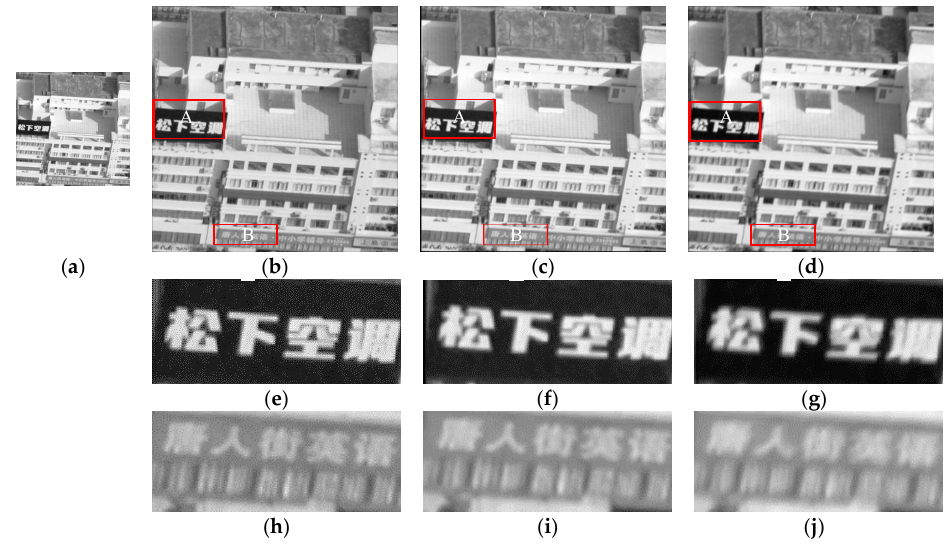
Figure 15. Actual results of the second set of experiments using the three methods. The images enclosed in a red box are the details of the three different algorithms. ( a ) Original LR image; ( b ) image based on the proposed algorithm; ( c ) image based on the blind SR reconstruction algorithm; ( d ) image based on the bicubic interpolation algorithm; ( e ) is the detail of reconstruction in region A by the proposed algorithm; ( f ) is the detail of reconstruction in region A by the blind SR reconstruction algorithm; ( g ) is the detail of reconstruction in region A by the bicubic interpolation algorithm; ( h ) is the detail of reconstruction in region B by the proposed algorithm; ( i ) is the detail of reconstruction in region B by the blind SR reconstruction algorithm; and ( j ) is the detail of reconstruction in region B by the bicubic interpolation algorithm. Table 7. The nominal values of metric Q of three reconstructed images in the second set of experiments. Image Reconstructed by Different Algorithms The Value of Q the proposed algorithm 40.1082 the blind SR reconstruction algorithm the bicubic interpolation algorithm